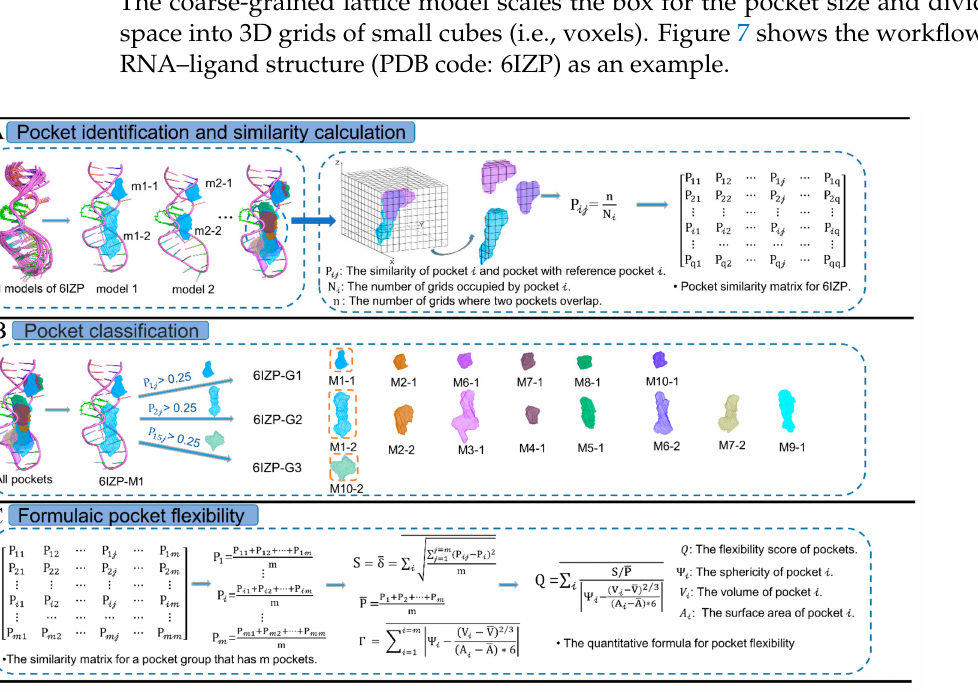
Figure 7. The workflow of the quantifying pockets’ flexibility. ( A ) Calculating the similarity of pockets of all the structural models of a complex, such as an RNA–ligand complex (PDB code: 6IZP). ( B ) Dividing pockets into different groups based on pocket similarity. ( C ) Calculating the flexibility score of a pocket